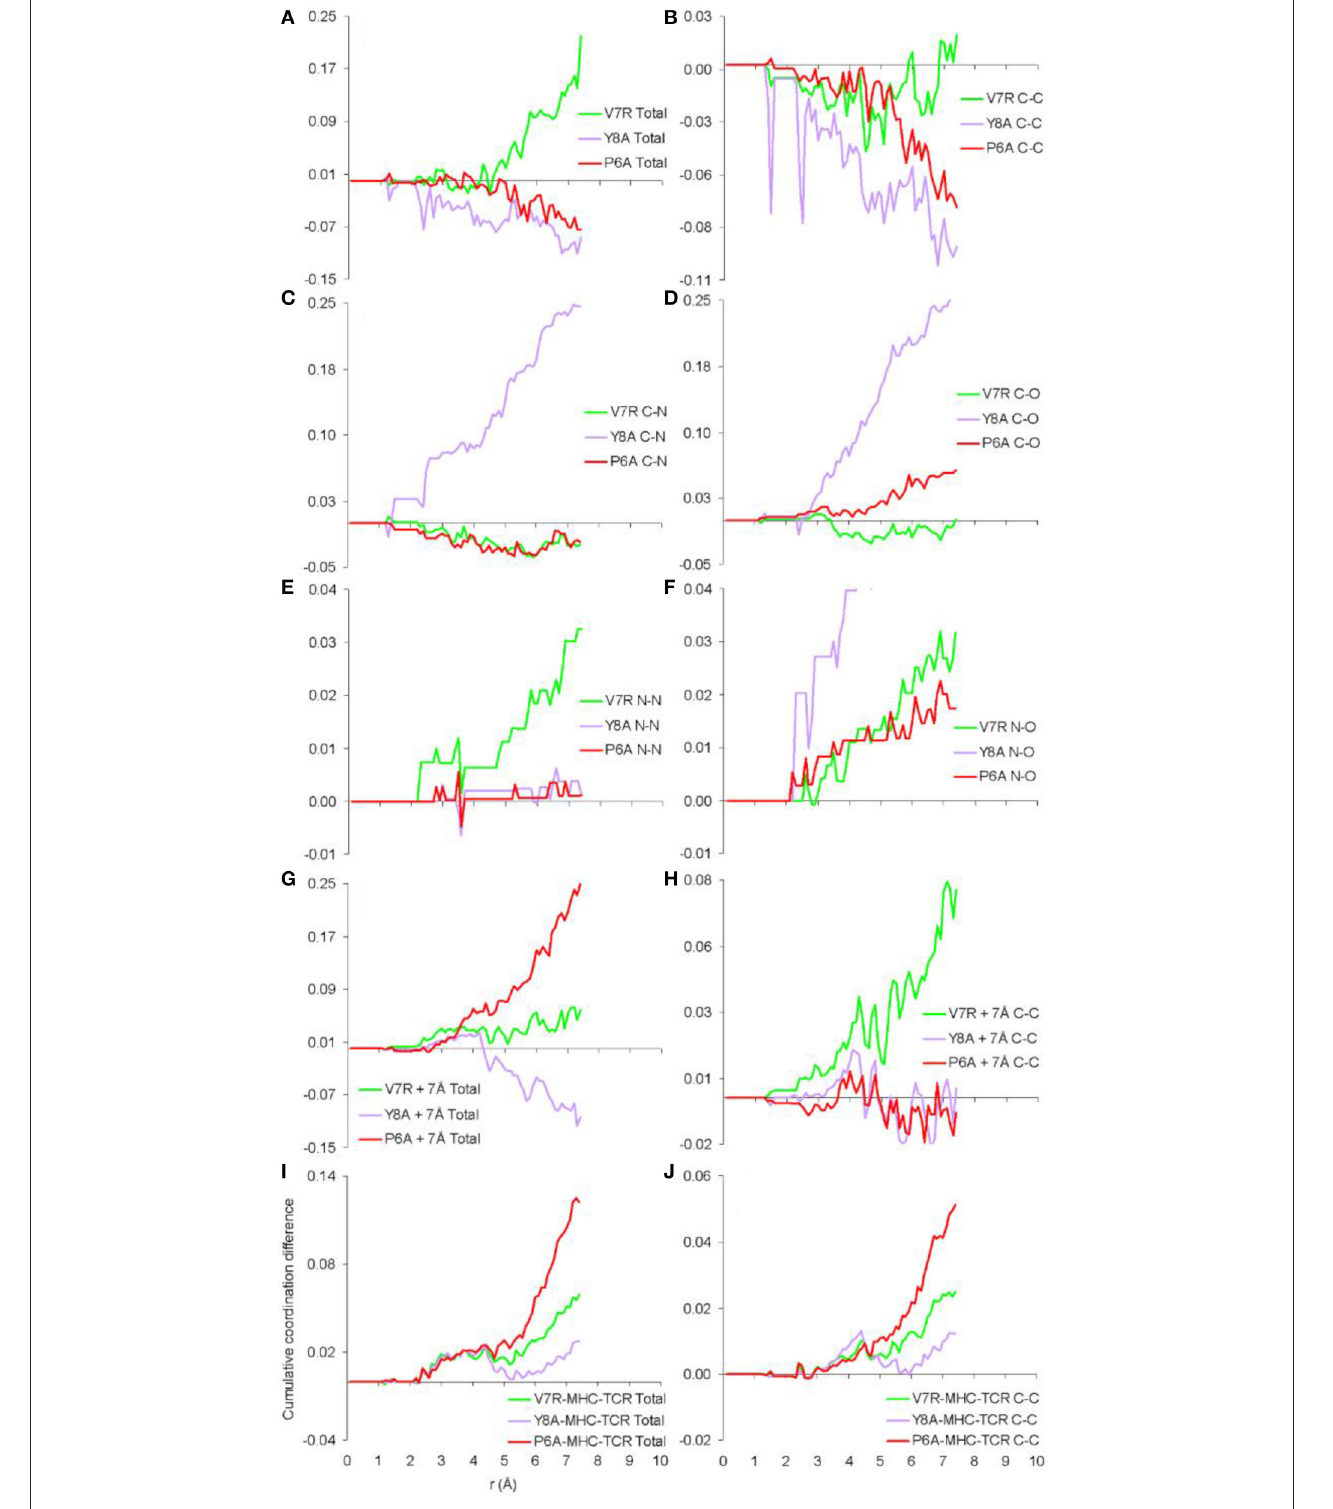
FIGURE 4 | Cumulative coordination differences of unprotonated structures in respect to Tax. From (A–F) single peptides, (G,H) peptides and a surrounding shell inclusive of atoms up to 7Å from each of the peptide atoms and (I,J) the entire pMHC-TCR complexes.